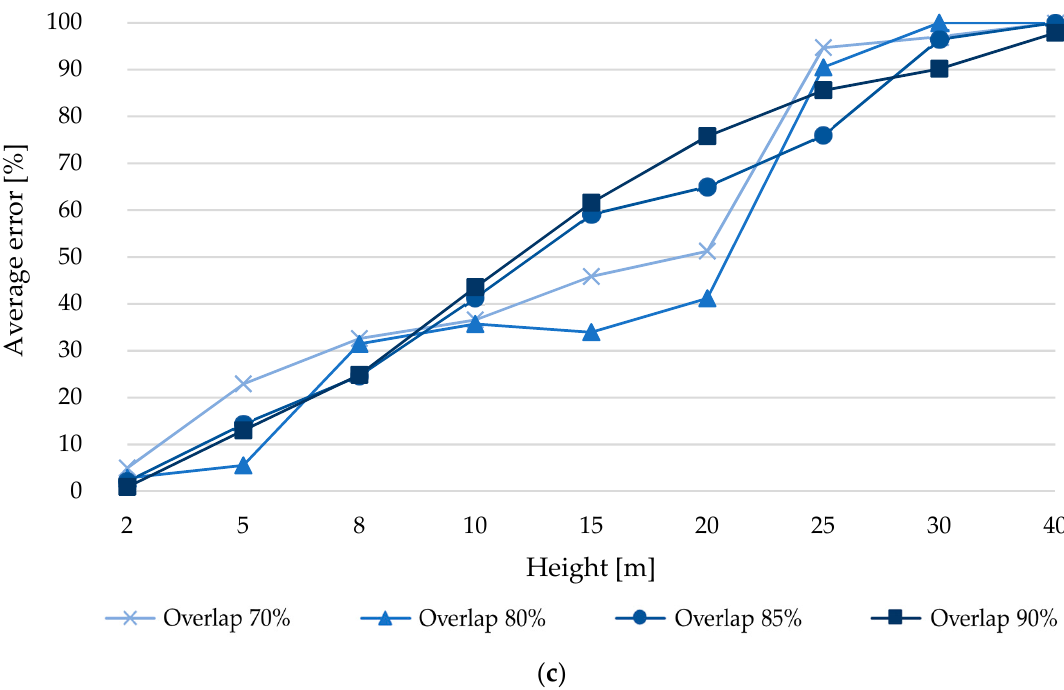
Figure 10. Average relative volume error behavior for different severity levels when varying overlap and height for vertical image acquisition (90°). ( a ) low severity; ( b ) mean severity; ( c ) high severity.